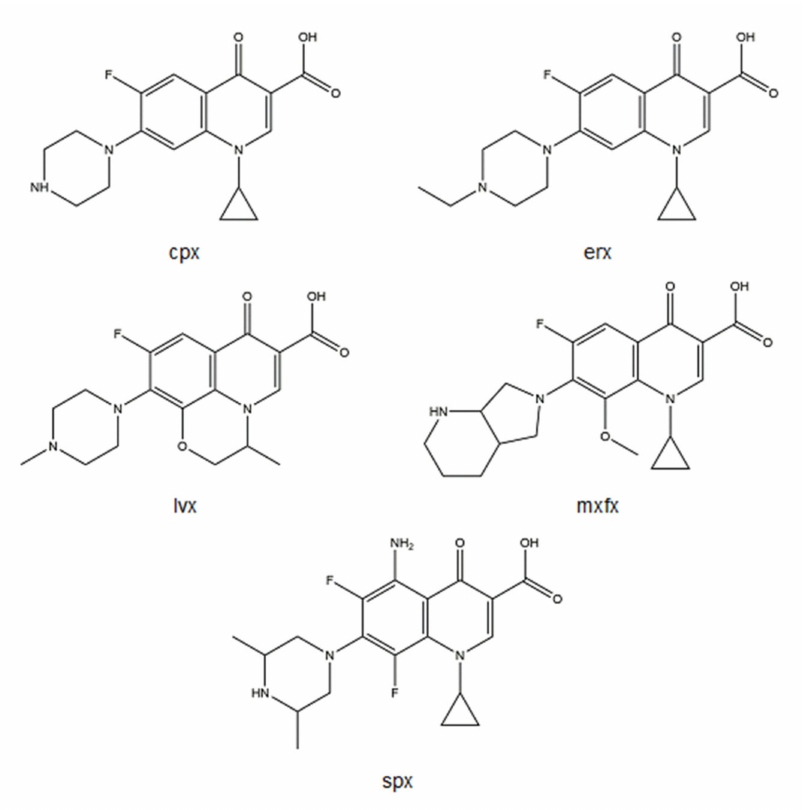
Figure 4. Structures of cpx, erx, lvx, mxfx, and spx, drawn using ChemDraw Professional